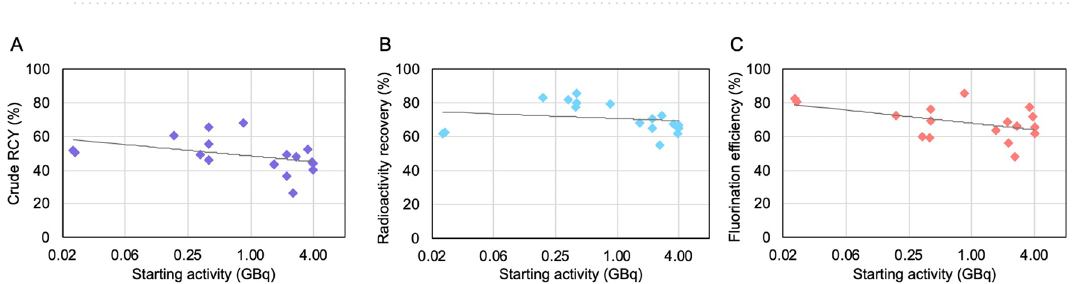
Figure 7. Performance of crude [ 18 F]FBB droplet-based radiosynthesis as a function of starting